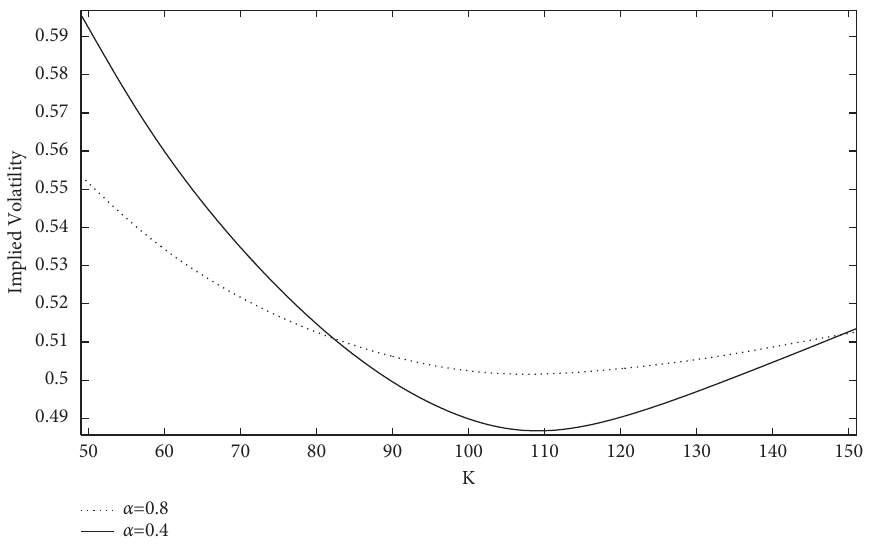
Figure 3: The implied volatility smile with different α